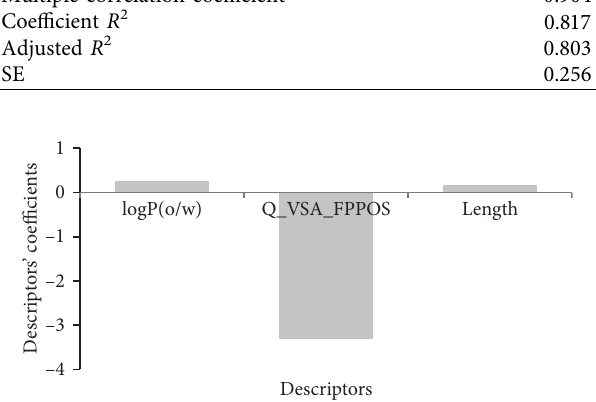
Figure 4: Contribution of each descriptor from model 02 to bi- ological